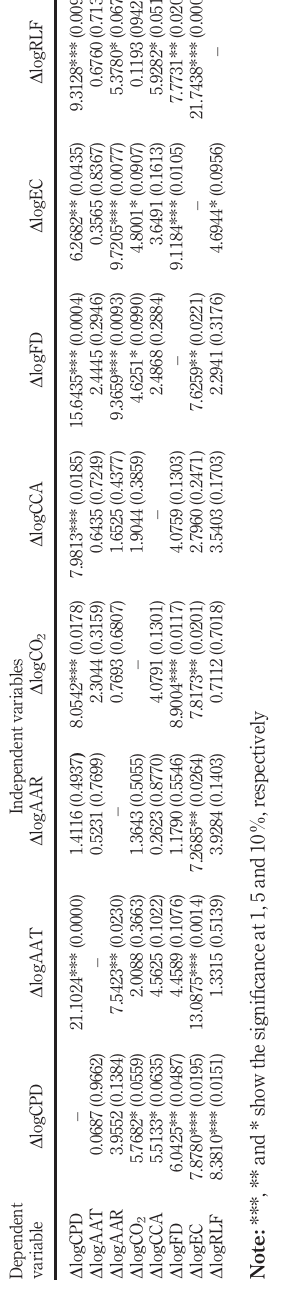
Table 4. VECM-based ganger causality